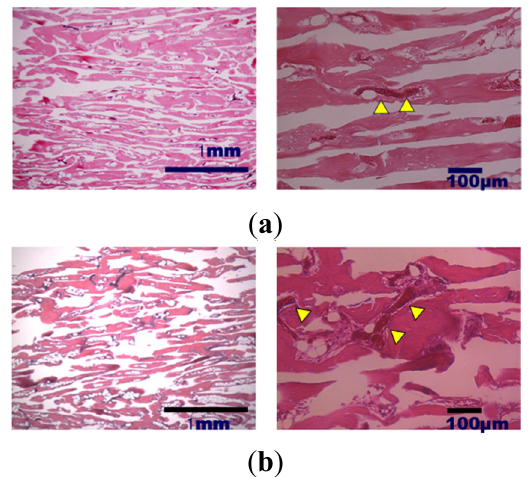
Figure 4. Histological analysis of decalcified specimens of UDPHAp by hematoxylin-eosin staining performed 52 weeks ( a ) and 104 weeks ( b ) after transplantation. Capillaries were observed at higher magnification (yellow arrow